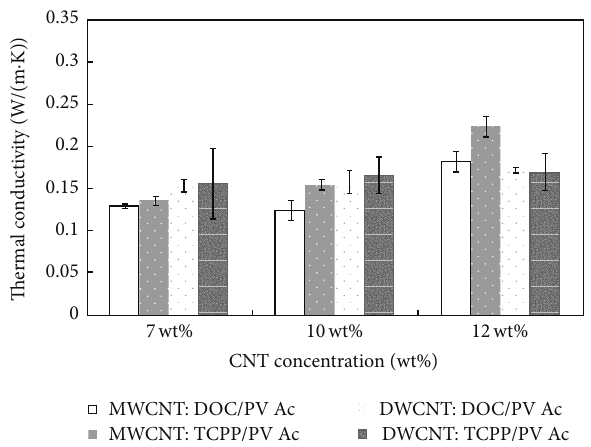
Figure 10: Thermal conductivity of sodium deoxycholate (DOC) and meso-tetra(4-carboxyphenyl)porphine (TCPP) stabilized sys- tems containing different percentages of carbon nanotubes [81].